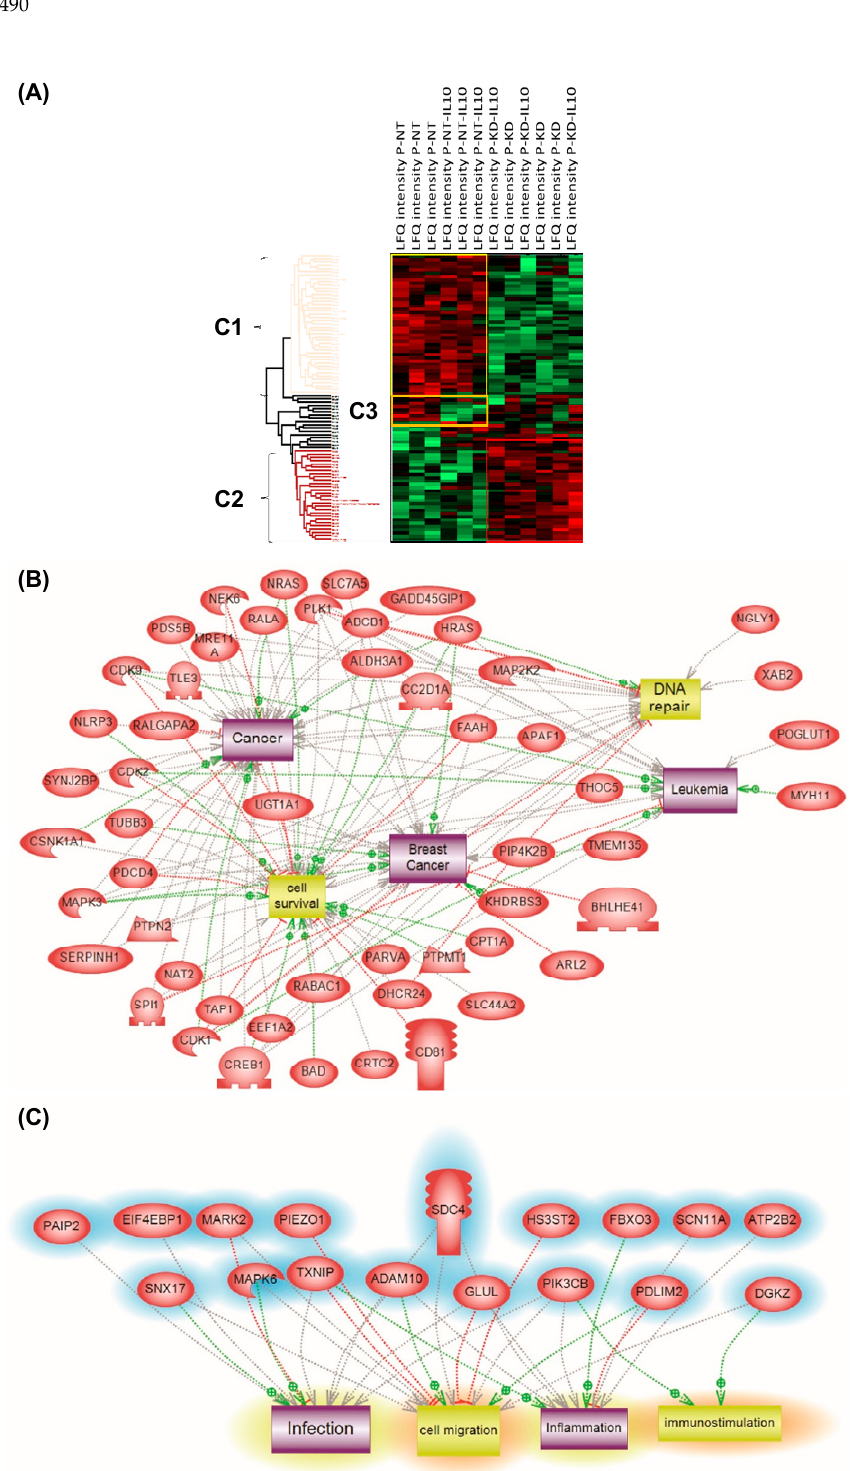
Figure 7. ( A ) Analysis of the global proteome of PC1/3KD macrophages stimulated with IL-10. NR8383 control (NT) and PC1/3 (KD) macrophages were stimulated (NT-IL10 or KD-IL10) or not with 20 ng/mL of IL-10 for 24 h. The cells were lysed and digested by trypsin during FASP (amicon 30 kDa). The peptides were analysed by mass spectrometry. Protein identification was done using MaxQuant software and then analysed on Perseus. A Heatmap was generated to visualize the differences in relative protein quantities between macrophages under the different conditions. 4 clusters were supervised. Bands C1–C3 corresponds to subnetwork analyses. ( B ) corresponds to Cluster 1 and ( C ) to Cluster 2. The results were obtained from three independent experiments.